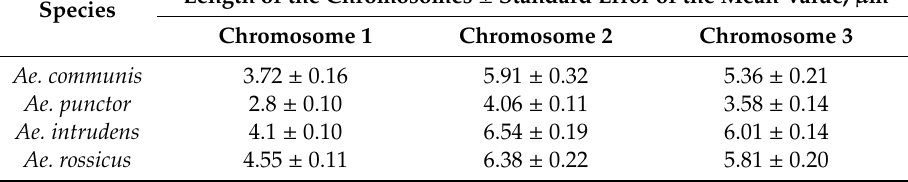
Table 1. Mean lengths of each chromosome of four Aedes mosquito species ( Ae. communis , Ae. punctor , Ae. intrudens , and Ae. rossicus